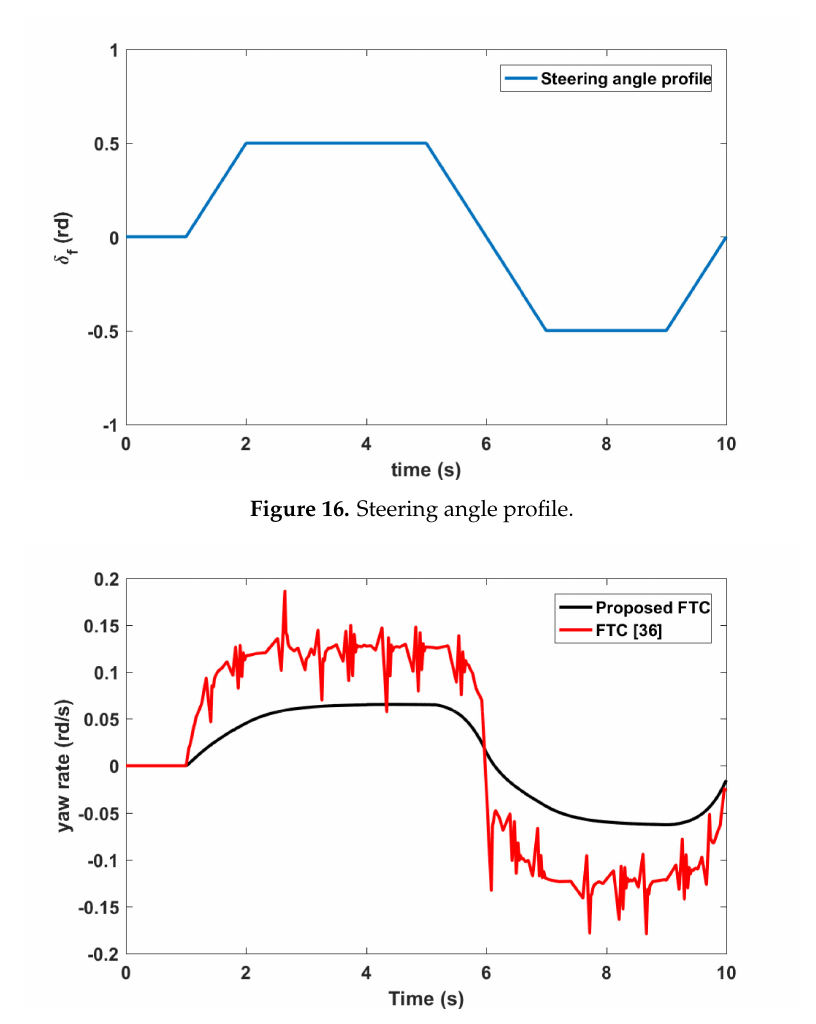
Figure 17. Vehicle output Yaw rate